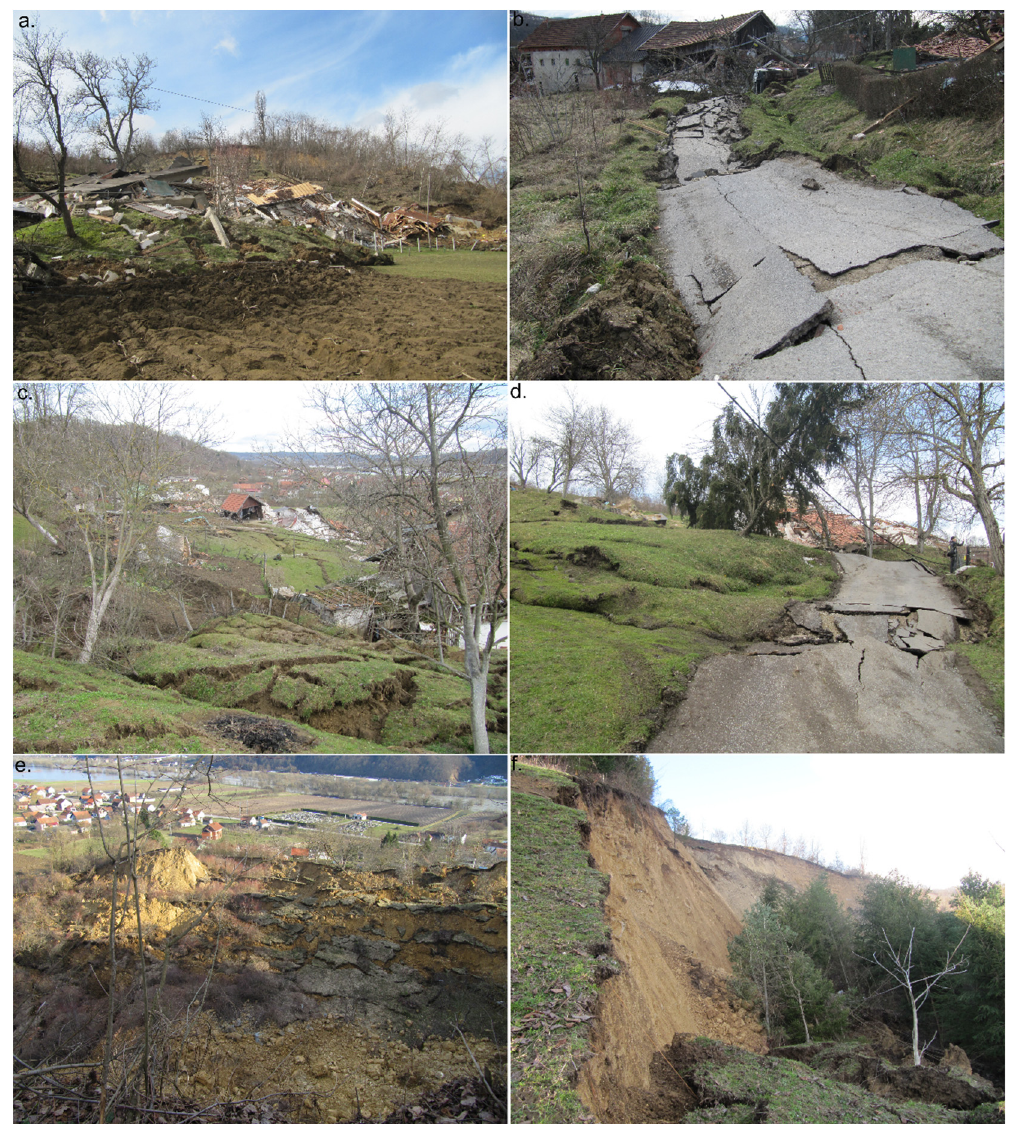
Figure 3. Hrvatska Kostajnica landslide damages: ( a ) completely destroyed houses; ( b ) completely destroyed road and damaged objects; ( c ) cracks and heavy terrain deformations; ( d ) flow like deformations on terrain surface; ( e ) view from main scarp toward flooding Una River; ( f ) landslide main scarp—almost 30 m at the highest point (photos by Croatian Geological Survey (CGS), day after the event, 14 March 2018).